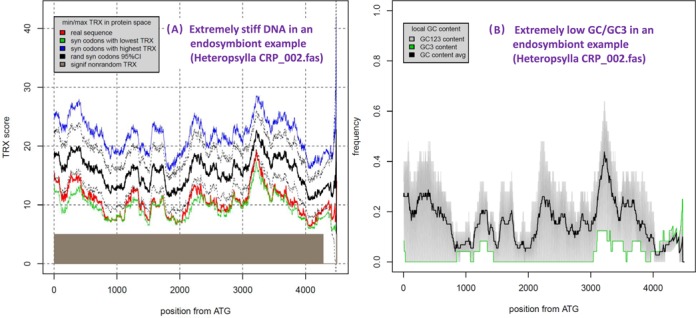
The intrinsic DNA flexibility and GC3 for a typical gene from the extreme psyllid endosymbiont, Carsonella sp in Heteropsylla. Example plots of (A) observed (red), minimum (green), maximum (blue) and average synonymous (black) intrinsic flexibility TRX scores and (B) respective trends in overall GC content (black), GC content in each reading frame (gray) and GC3 (green). Supplementary File D has plots for all known Carsonella genes.